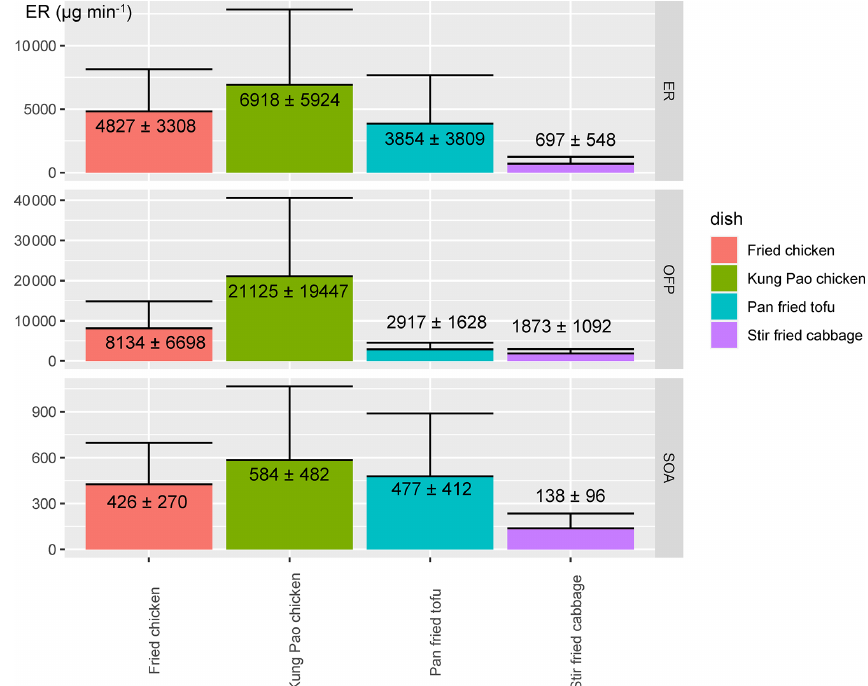
Figure 2. Emission rate (ER), ozone formation potential (OFP), and secondary organic aerosol (SOA) estimation from emissions of fried chicken, Kung Pao chicken, pan-fried tofu, and stir-fried cabbage. The unit of the y axis is µgmin − 1 .